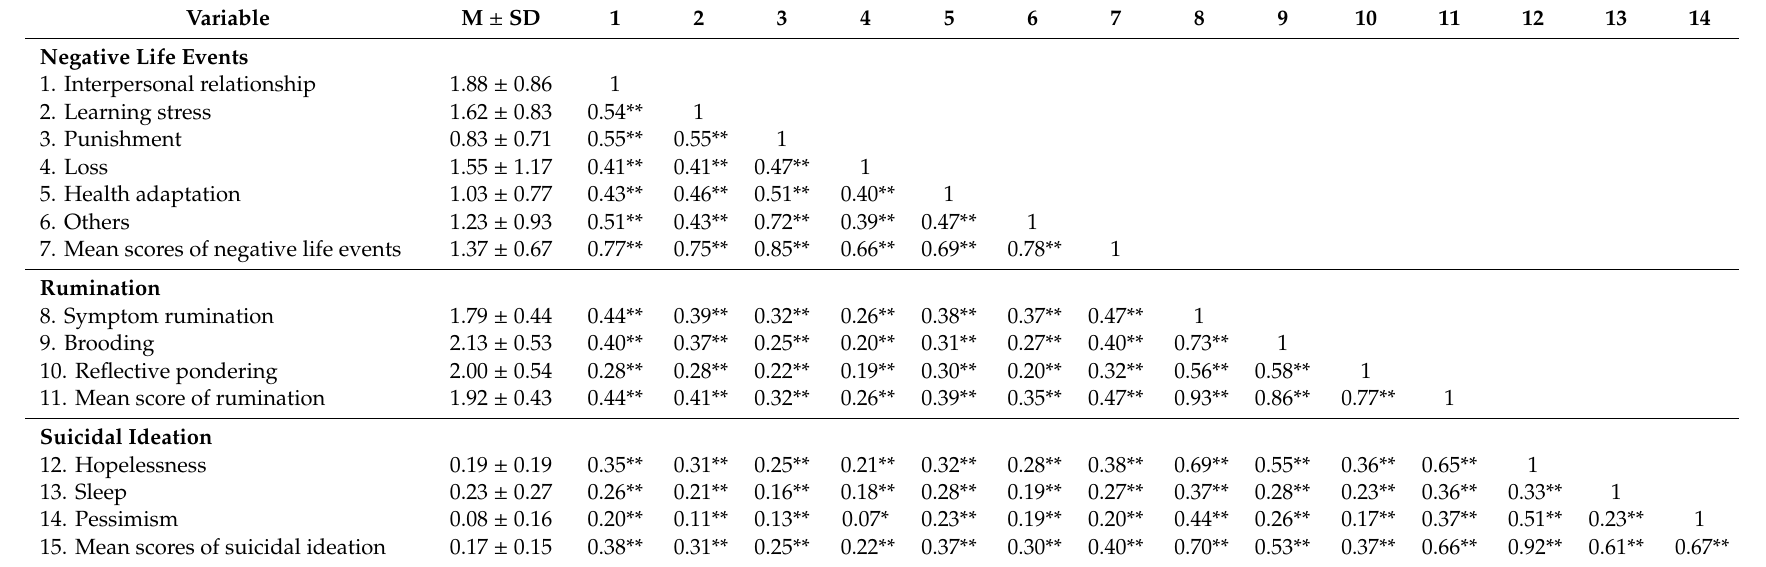
Table 2. Correlation matrix between negative life events, rumination, and suicidal ideation ( n = 894).